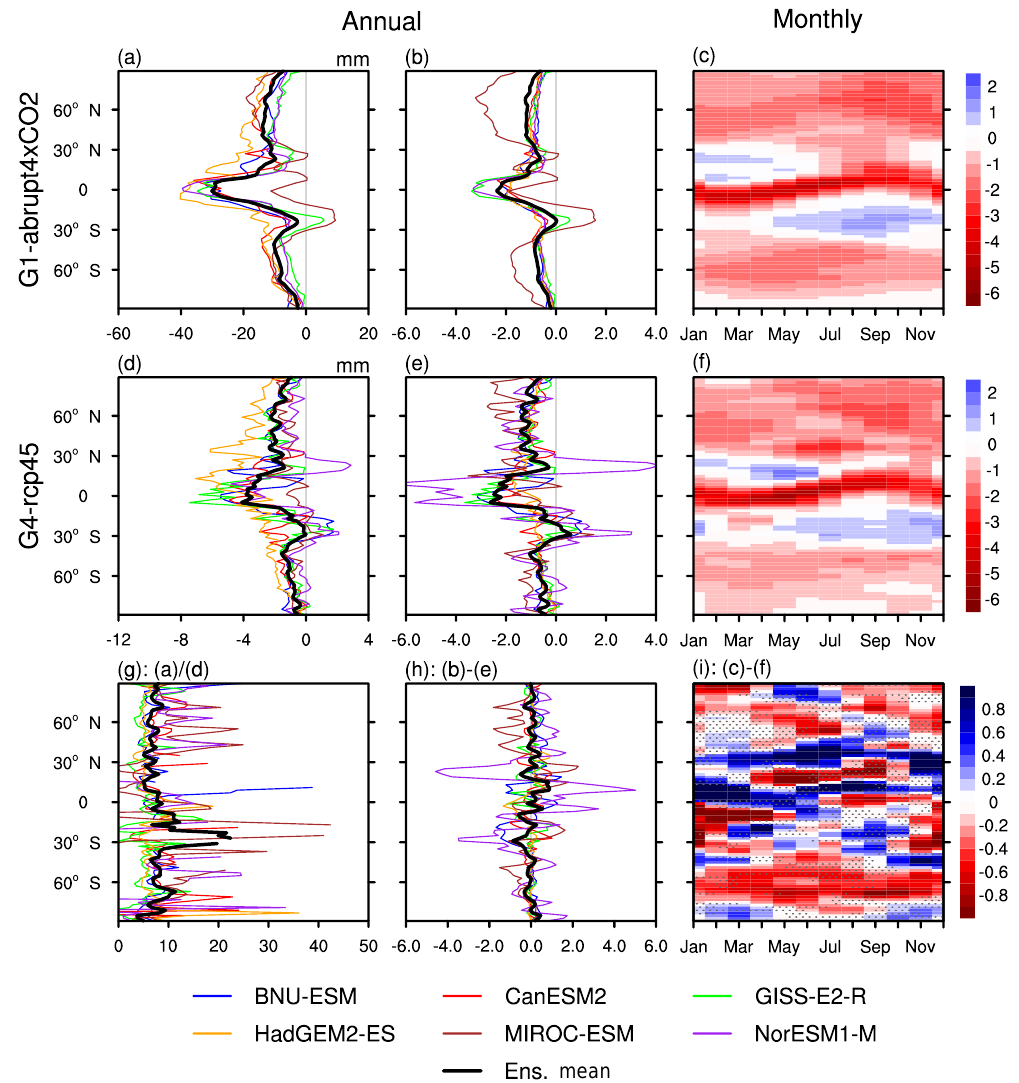
Figure 8. Absolute difference in annual zonal mean in the extreme precipitation Rx5day (a, d) . Normalized difference with respect to annual zonal mean (b, e) and monthly zonal mean (c, f) in Rx5day: (a, b, c) G1 − abrupt4 × CO2, (d, e, f) G4 − rcp45, (g) the ratio between absolute G1 − abrupt4 × CO2 and G4 − rcp45, (h) the annual zonal mean difference between normalized G1 − abrupt4 × CO2 and G4 − rcp45, and (i) the monthly zonal mean difference between normalized G1 − abrupt4 × CO2 and G4 − rcp45 taken over the 40-year analysis period. In panel (i) , blue colours indicate relatively greater changes with G4 and red colours indicate this with G1; stippling indicates regions where fewer than five of six models agree on the sign of the model response. Three by three point smoothing was applied to the seasonal latitude